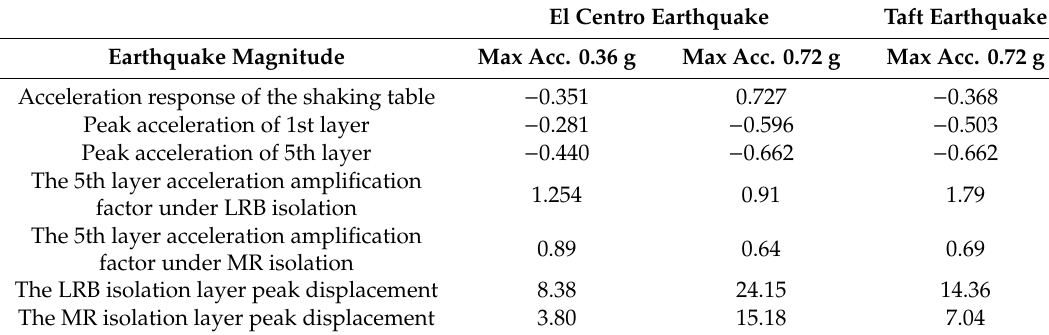
Table 3. The peak response isolating by the lead rubber bearing